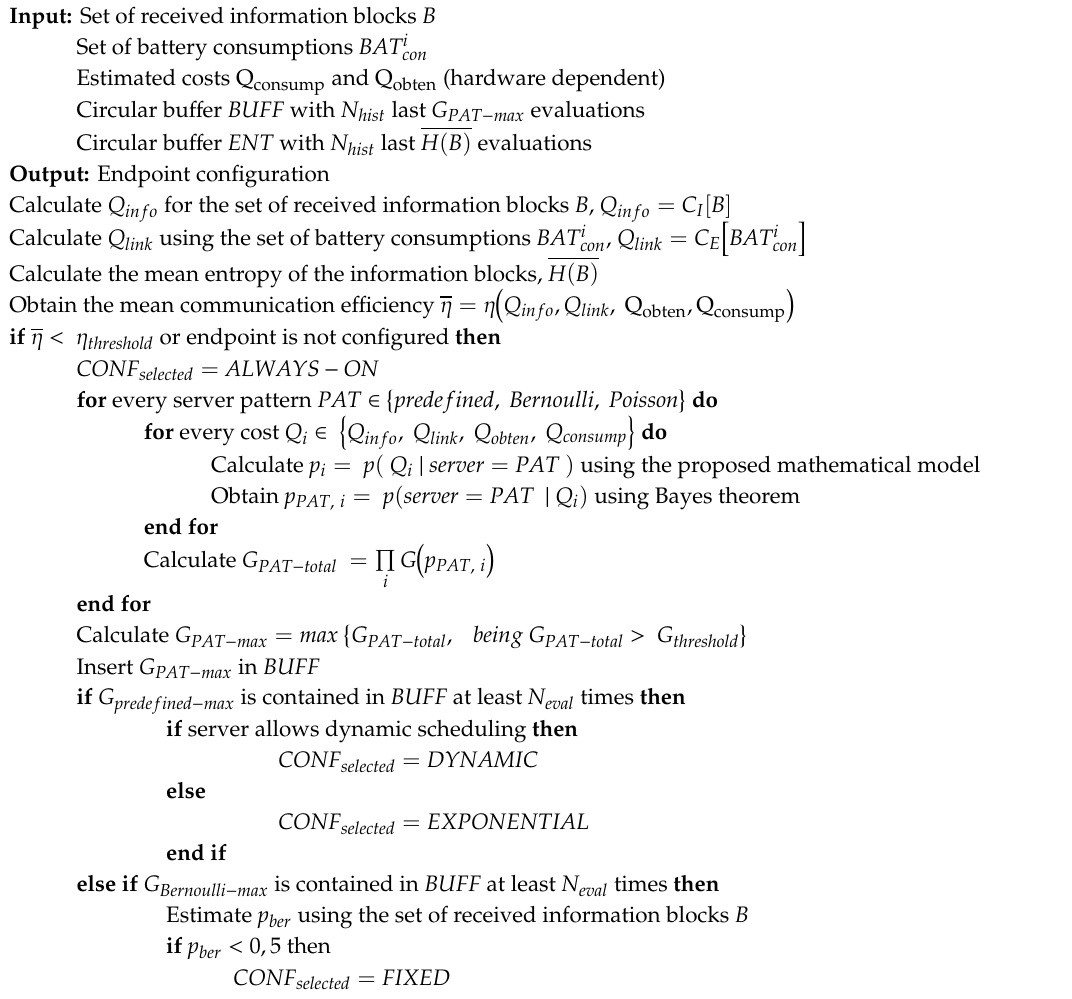
Algorithm 1: Dynamic Communication E ffi ciency